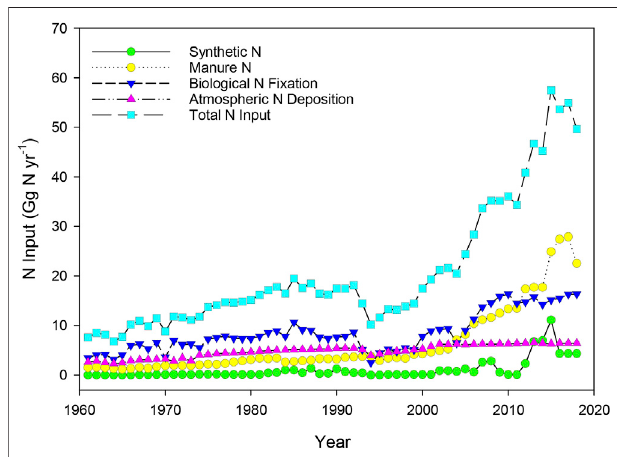
FIGURE1| Historical changesinNinputto crops fromdifferentsources in farmlands of